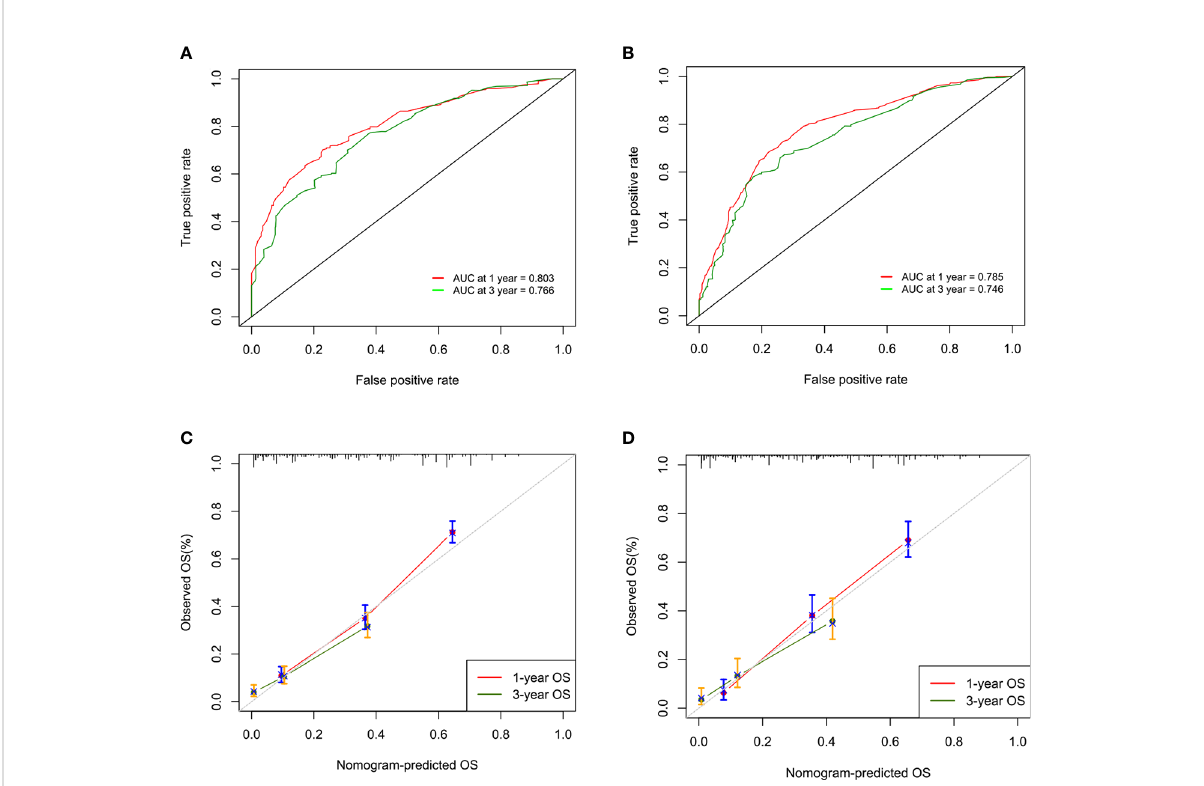
FIGURE 2 ROC curves and AUCs for 1-year and 3-year overall survival (OS) in the training cohort (A) and the validation cohort (B) . Calibration curves of 1-year and 3-year overall survival (OS) in the training cohort (C) and the validation cohort (D)